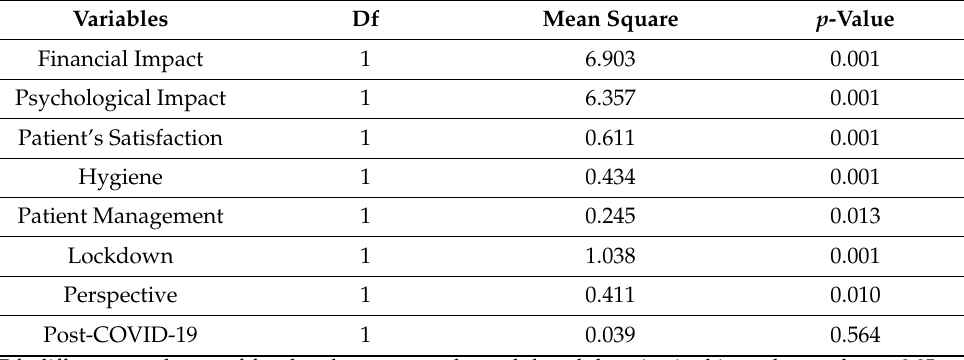
Table 5. Comparison of gender with dental domains.